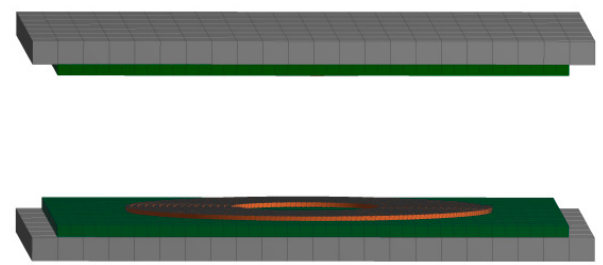
Figure 4. Model after meshing.